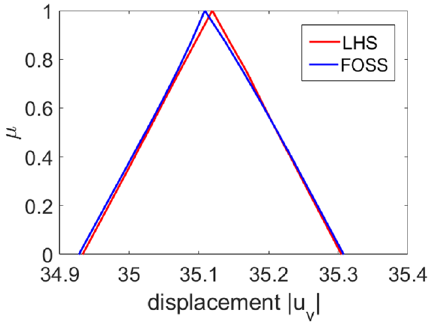
Fig. 19 Maximum fuzzy displacement for DACE models with LHS and FOSS